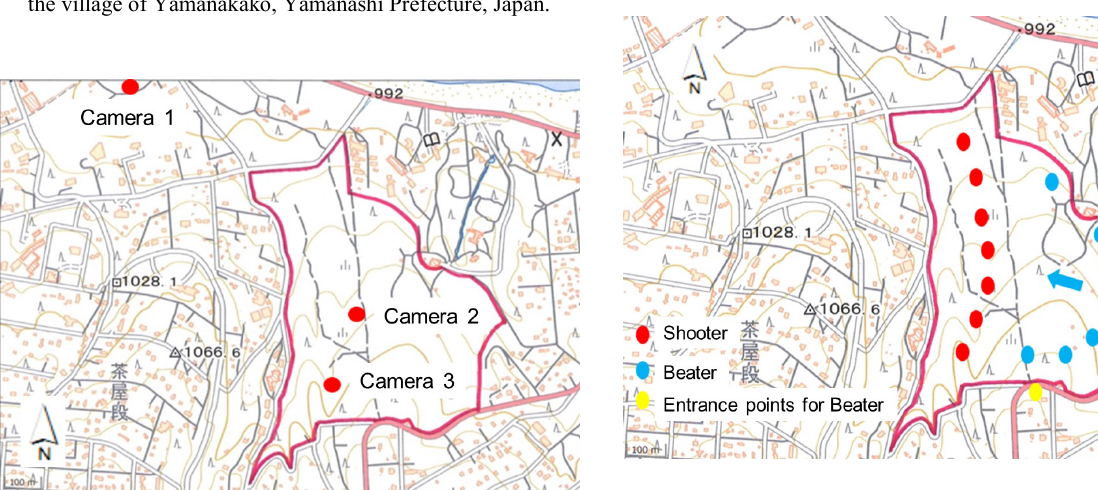
Figure 2 . Location of sensor cameras (Camera 1-3) in FIWSC. Red line shows the study area.